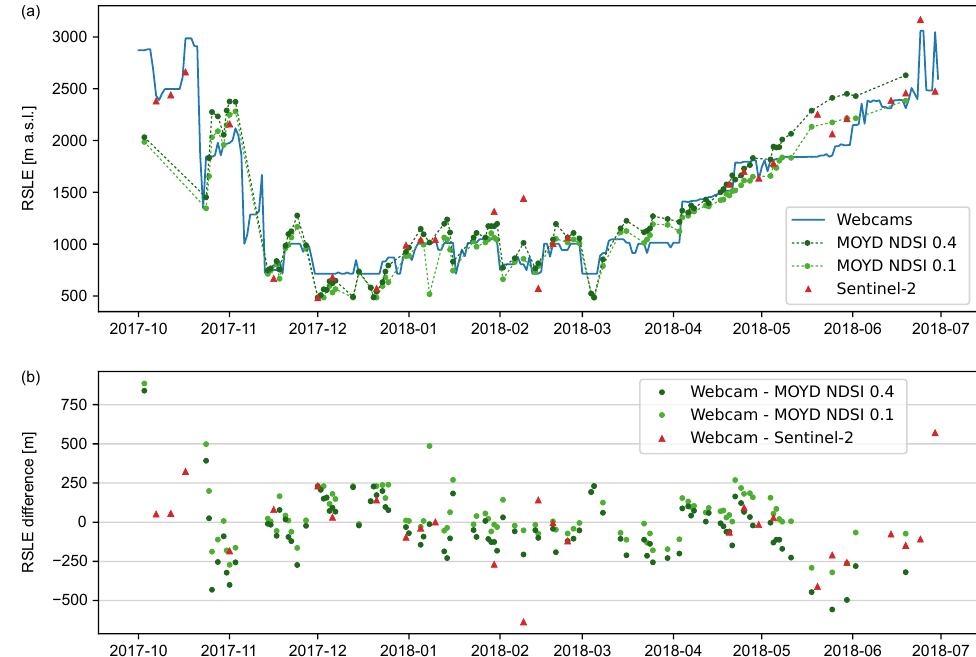
Figure 9. ( a ) Regional snow line elevation (RSLE) derived from webcams, MOYD, and Sentinel-2 snow-cover data sets and ( b ) differences between webcam RSLEs and MOYD/Sentinel-2